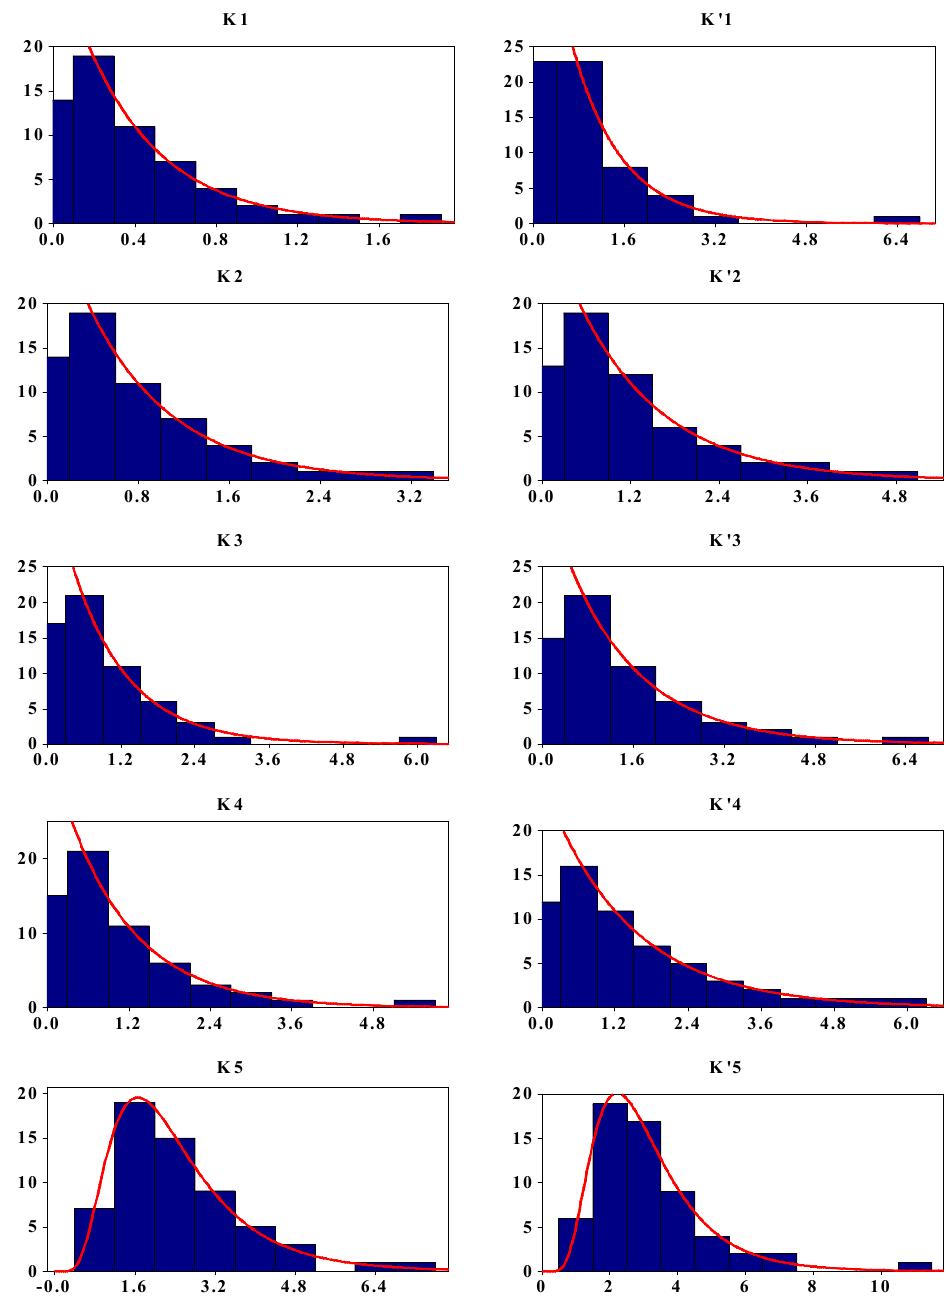
Figure 3. The histograms of generated random numbers by Lingo. Table 11. The characteristics of generated random numbers by Lingo.